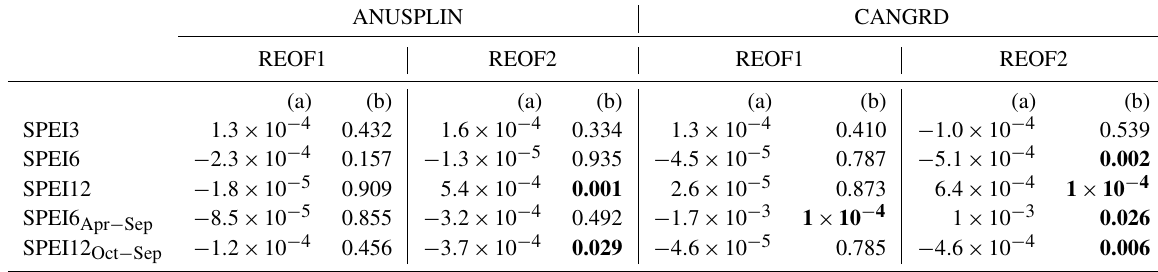
Table 4. Long-term (1950–2013) trends of monthly time series (RPCs) for the first two REOFs of SPEI at various timescales. The slope year − 1 (a) and p value (b) is indicated, with significant ( p < 0 . 05) trends shown in bold. ANUSPLIN CANGRD REOF1